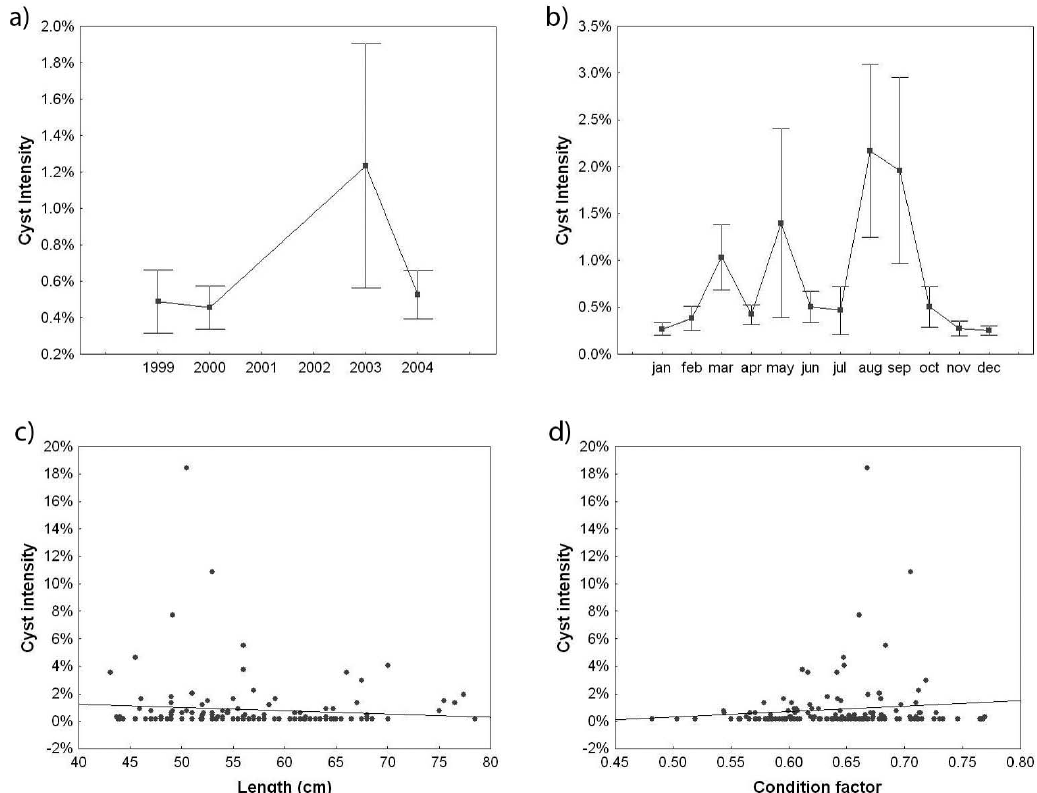
Fig. 6. – For European hake: a) annual mean ± standard error of cyst intensity; b) monthly mean ± standard error of cyst intensity; c) linear relationship between cyst intensity and female length (y=0.022-0.0002x); and d) linear relationship between cyst intensity and female condi- tion factor